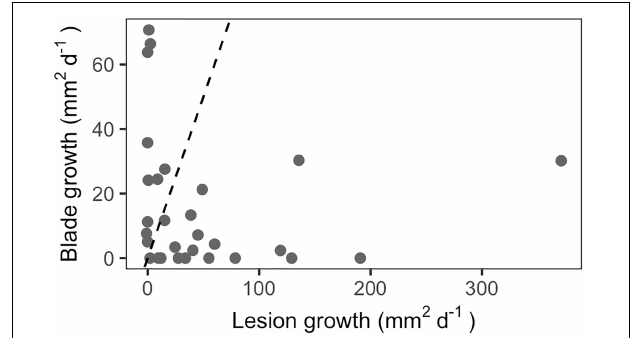
FIGURE 3 | In situ lesion growth rates outpaced blade growth rates among third-rank blades ( n = 29). Dashed line indicates the 1:1 line.